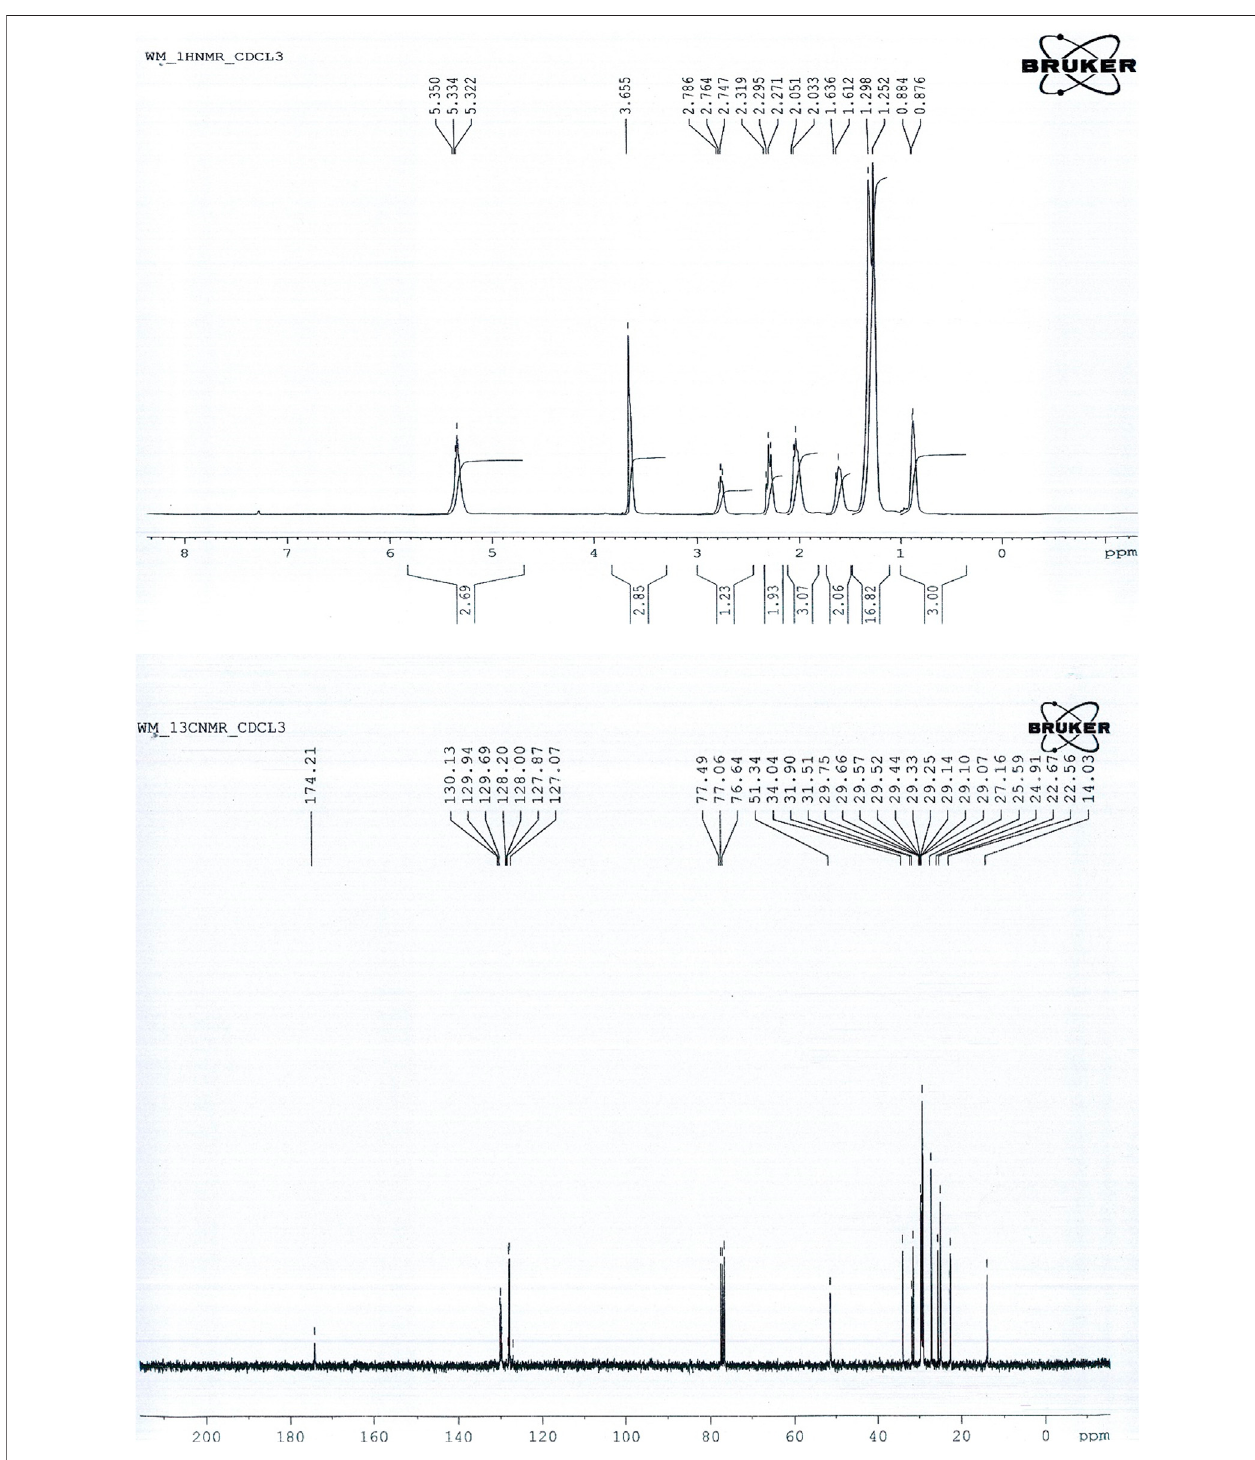
FIGURE 7 | H 1 NMR (upper), and C 13 NMR (lower) spectrum of Cucumis melo var. agrestis biodiesel.